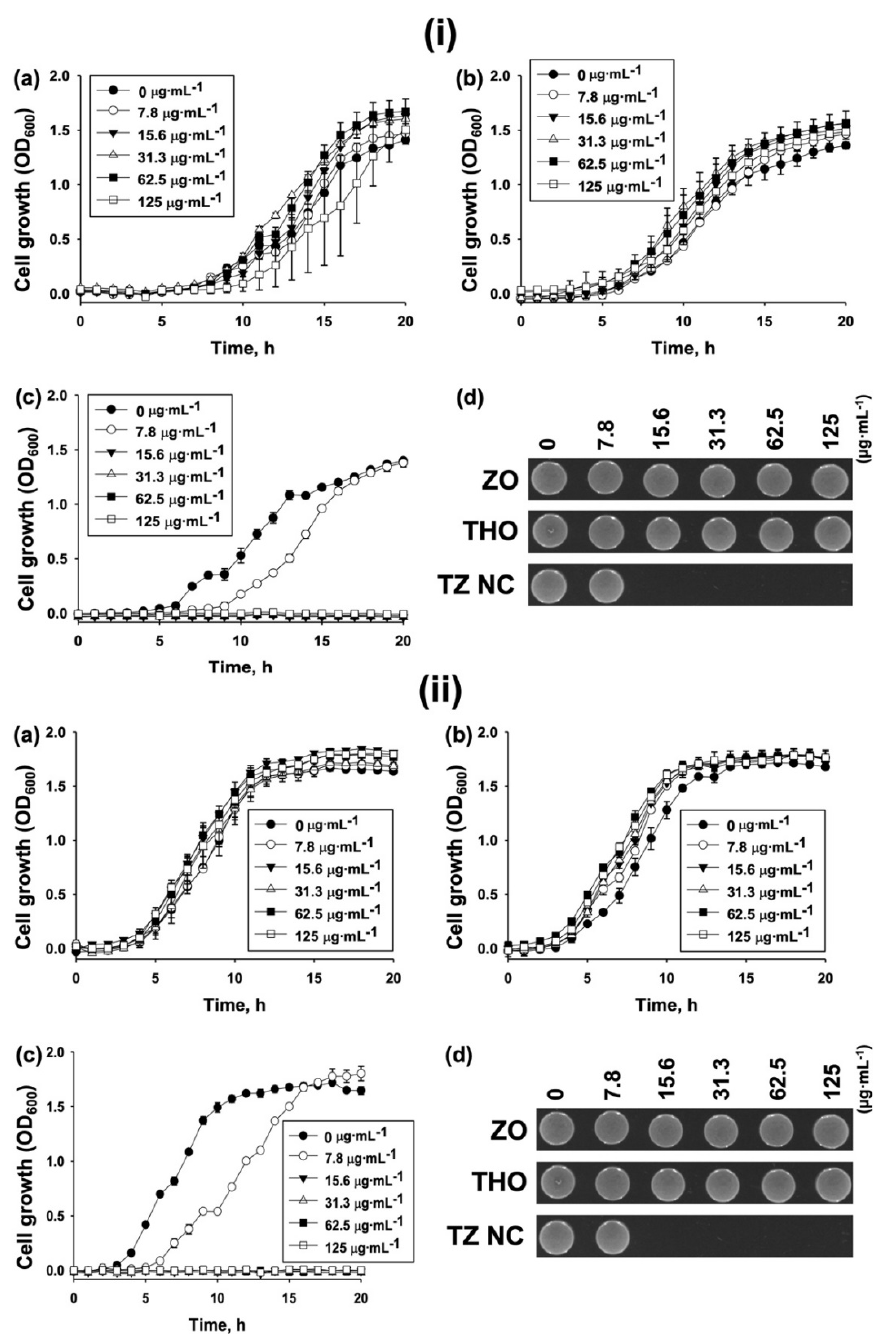
Figure 3. Growth curve analysis. ( i ) Growth of S. epidermidis strain (ATCC 14990) at an absorbance of 600 nm (OD 600 ) following treatment with different concentrations of ( a ) ZO, ( b ) THO, or ( c ) TZ NC for 20 h. The growth curve data were plotted as average values with standard deviations of n = 3 using SigmaPlot (ver. 12.5) (Systat Software Inc., San Jose, CA, USA). ( d ) Cell viability. ( ii ). Growth of MDR S. epidermidis strain (ATCC 12228) at OD 600 following treatment with different concentrations of ( a ) ZO, ( b ) THO, or ( c ) TZ NC for 20 h. The growth curve data were plotted as the average values with standard deviations of n = 3 using SigmaPlot (ver. 12.5) (Systat Software Inc., San Jose, CA, USA). ( d ) Cell viability. A fraction of cells from the end point of the growth curves were spotted on LB agar plates and incubated at 37 °C for 24 h. The plate images were captured using ChemiDoc TM MP (Bio-Rad, Hercules, CA, USA) and ImageLab TM Software (ver.5.2.1, Bio-Rad, Hercules, CA, USA). One of the representatives from n = 3 is presented.